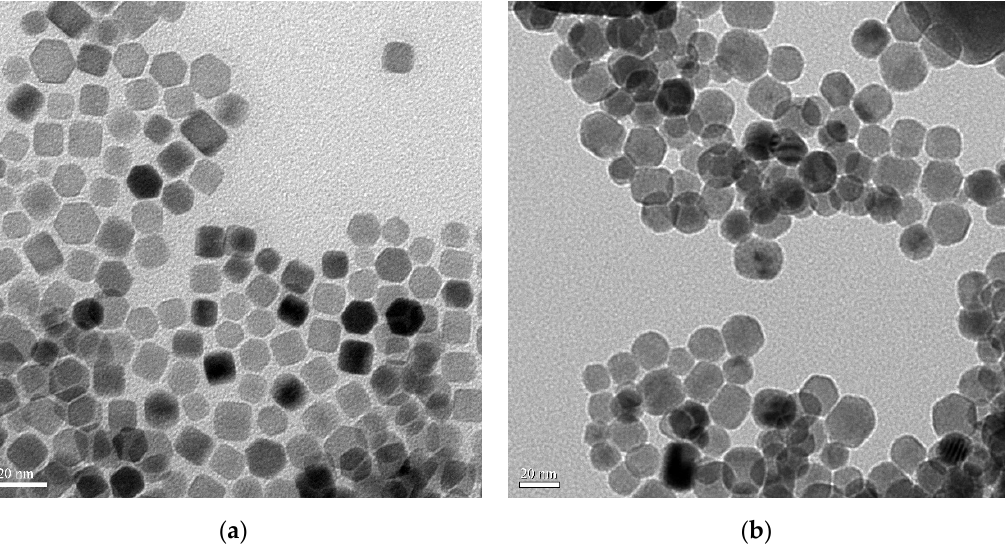
Figure 7. TEM images of ( a ) LaF 3 :Yb 3+0.20 , Er 3+0.02 core nanoparticles and ( b ) LaF 3 :Yb 3+0.20 , Er 3+0.02 @LaF 3 :Yb 3+0.20 core/shell nanoparticles.